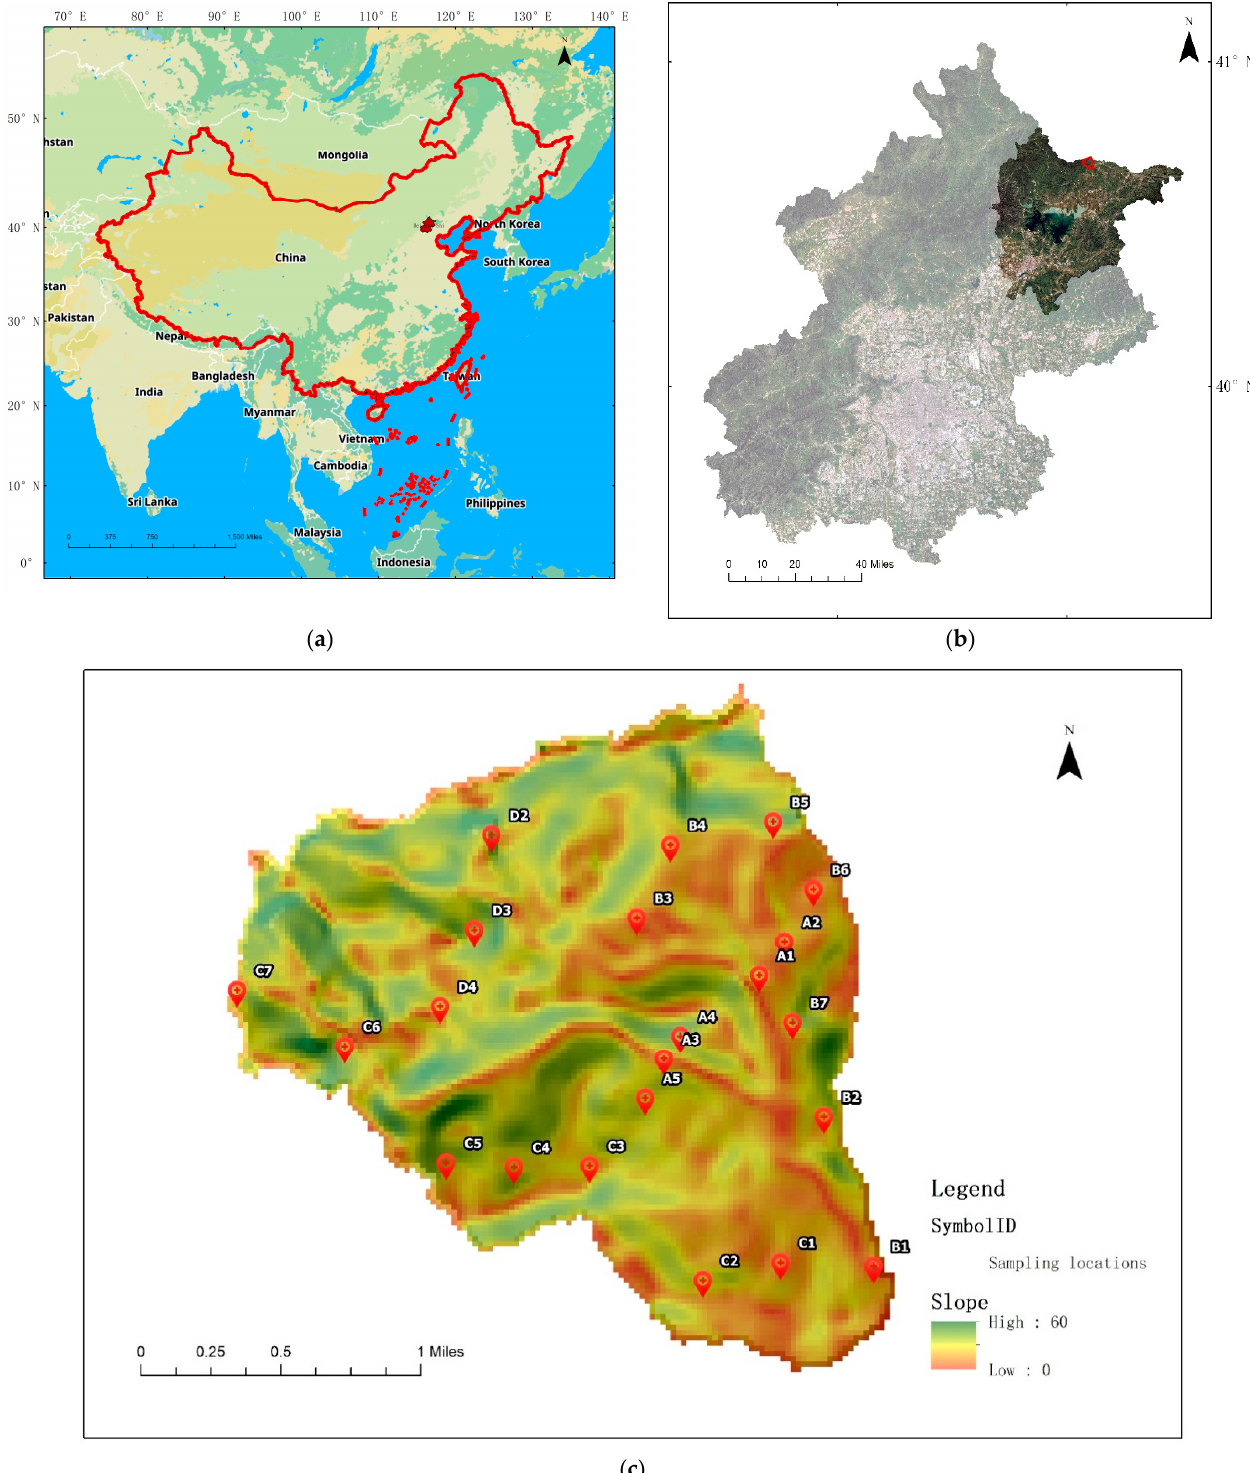
Figure 1. Location of the study area and distribution of the sampling sites. ( a ) Remote Sensing Image of China, the red area represents Beijing; ( b ) remote sensing image of Miyun District, Beijing, the red area represents Chaoguan Xigou watershed; and ( c ) topographic map of Chaoguan Xigou and distribution of sampling points.